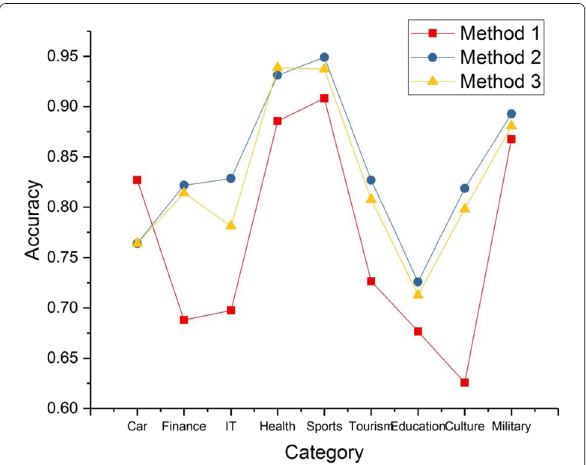
Fig. 6 Three kinds of special effects classification weight value updating method of